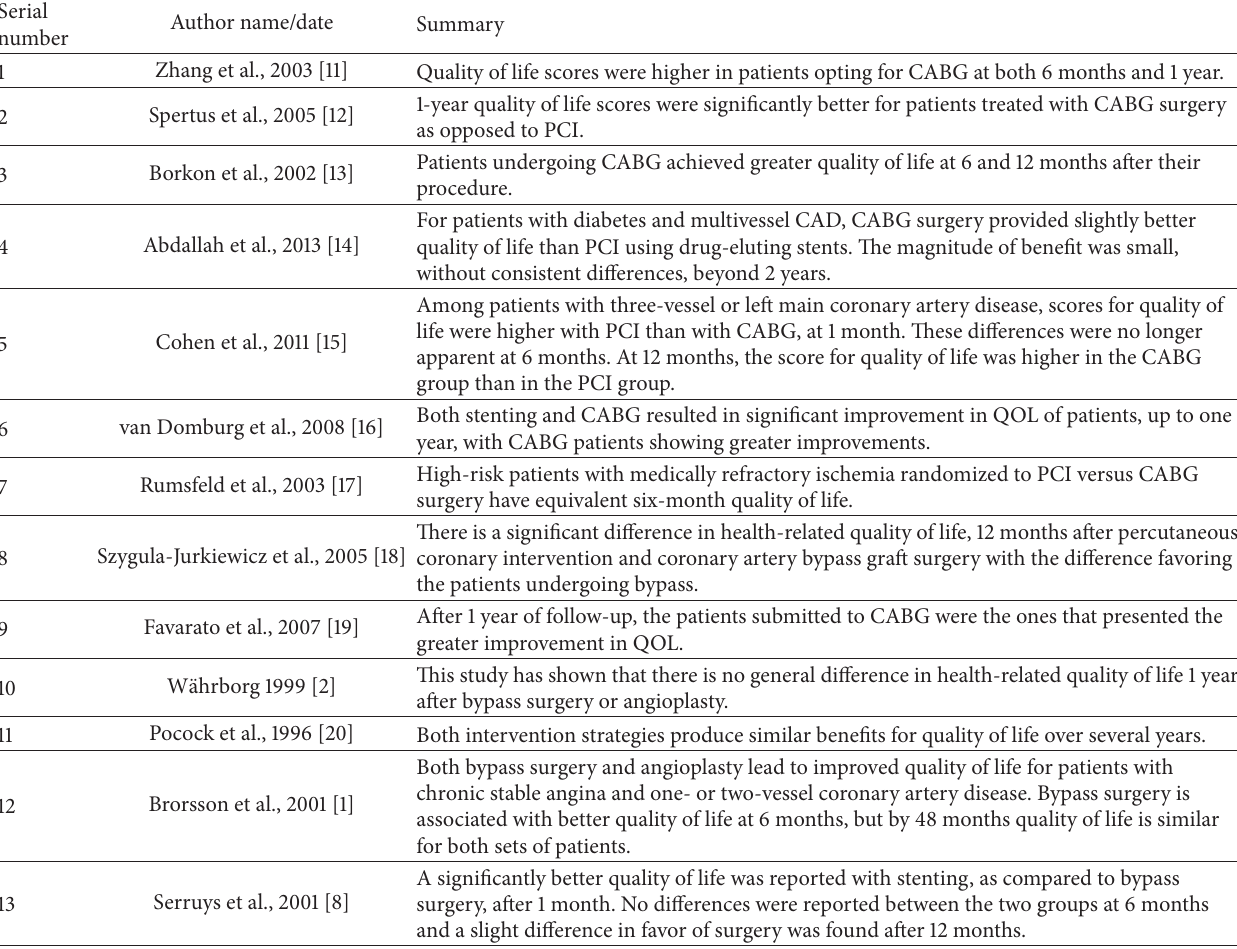
Table 2: A summary of the reviewed